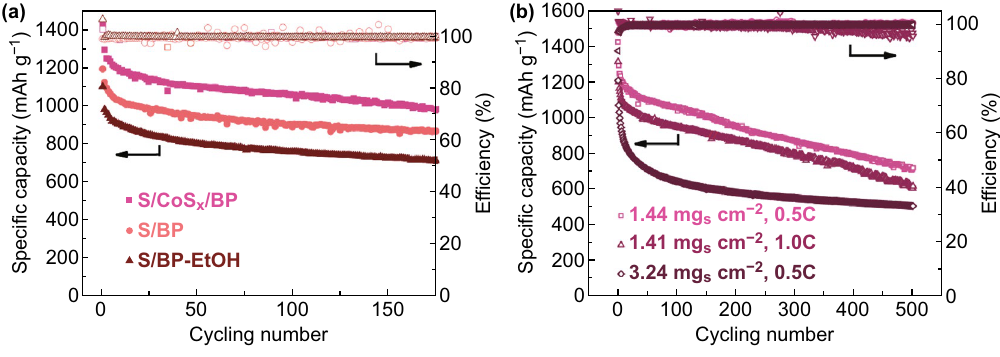
Fig. 6 a Cycling performance of S/Co x S/BP, S/BP and S/BP-EtOH at 0.5 C. b Continuous operation of S/Co x S/BP up to 500